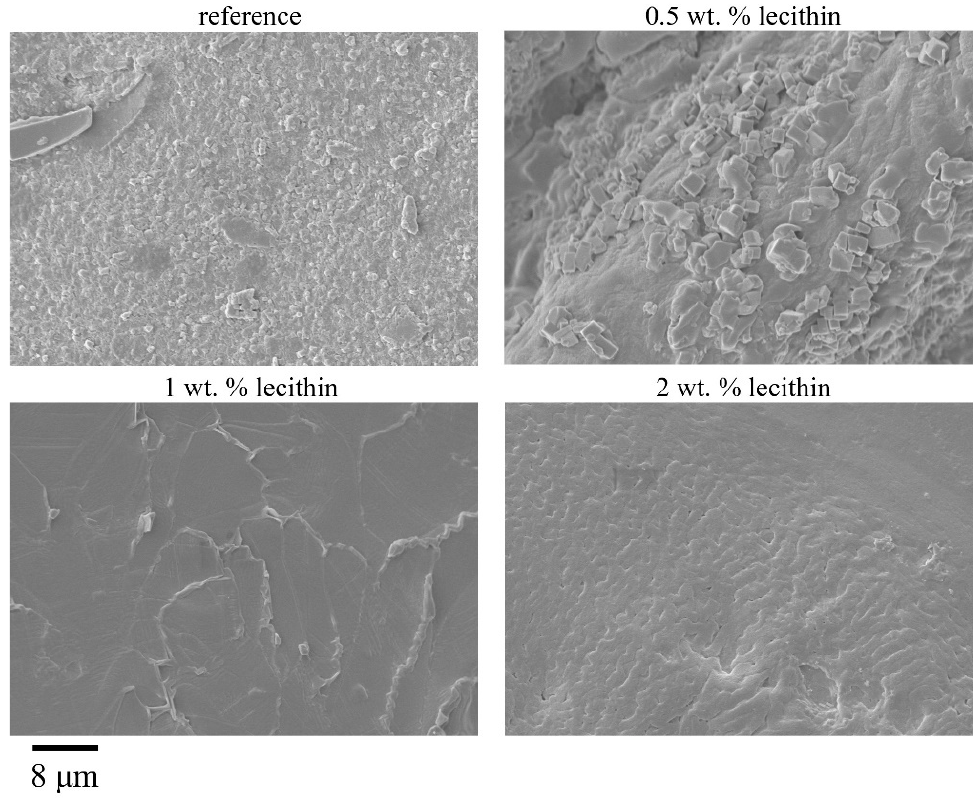
Figure 6. Surface morphologies of ionically crosslinked alginate xerogels with the addition of lecithin revealed by SEM. Magnification 5000×. Table 6. Specific surface area for ionically crosslinked alginate xerogels with the addition of lecithin determined by gas sorption.